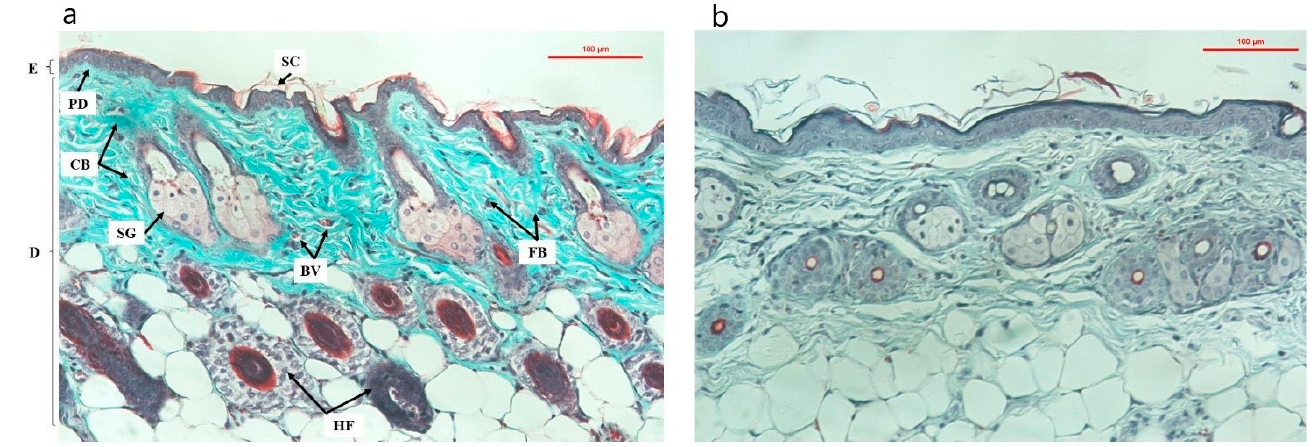
Figure 5. Mouse skin microstructure after 8 weeks of UVA (X20) irradiation (( a )—PC; ( b )—NC). E: epidermis; D: dermis; PD: papillary dermis ; CB: collagen bundles; SG: sebaceus glance; SC: stratum corneum; BV: blood vessels ; HF: hair folicle; FB: fibroplast [37] .